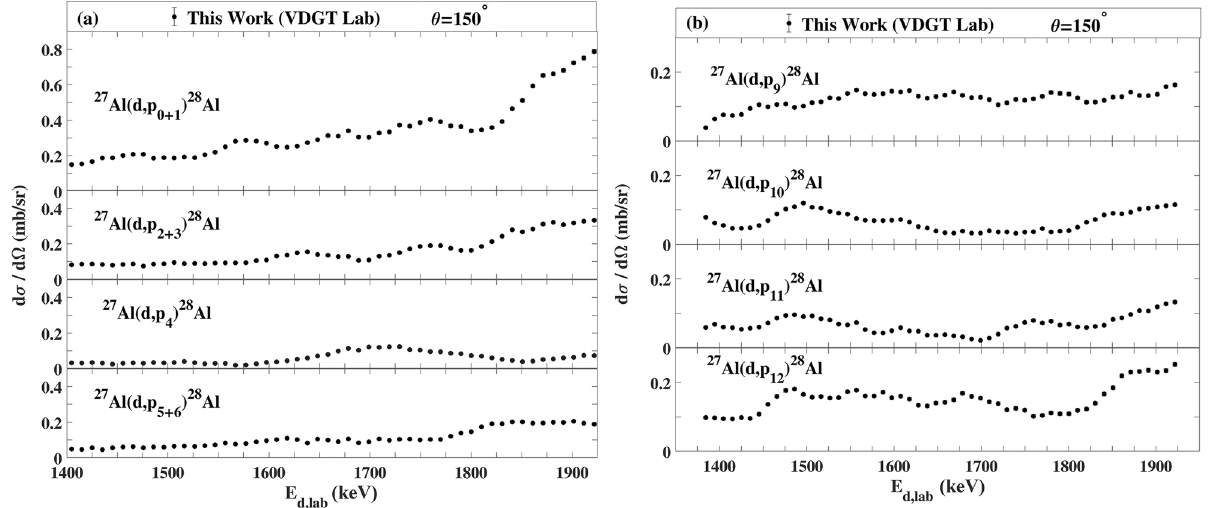
Figure 5. Differential cross section values for ( a ) 27 Al(d,p 0-6 ) 28 Al and ( b ) 27 Al(d,p 9–12 ) 28 Al reactions at scattering angle 150° at VDGT Lab in Tehran. The estimated uncertainties from counting statistics are smaller than the plotted symbols.